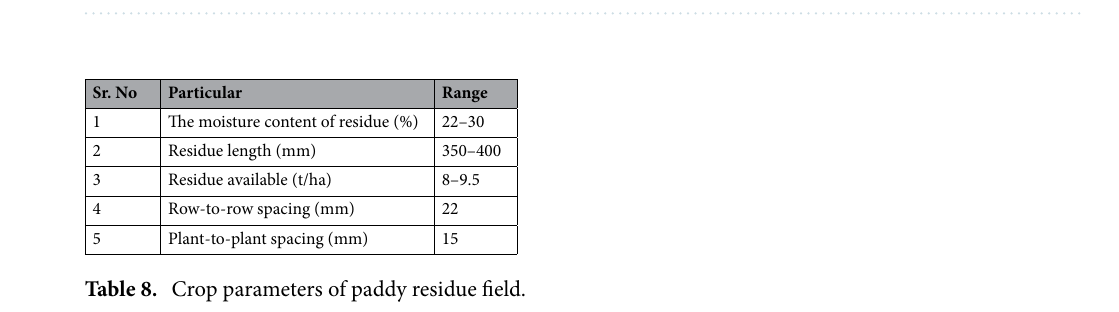
Table 7. Soil parameters of a combined harvested field.